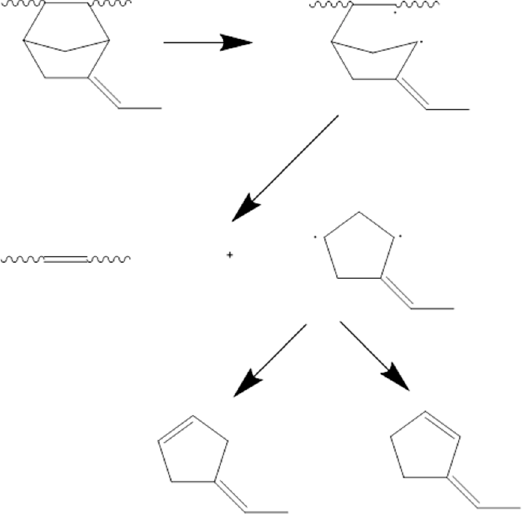
Scheme 2. Mechanism of formation of 4-ethylidene-1-cyclopentene (and 3-ethylidene-1-cyclopen-